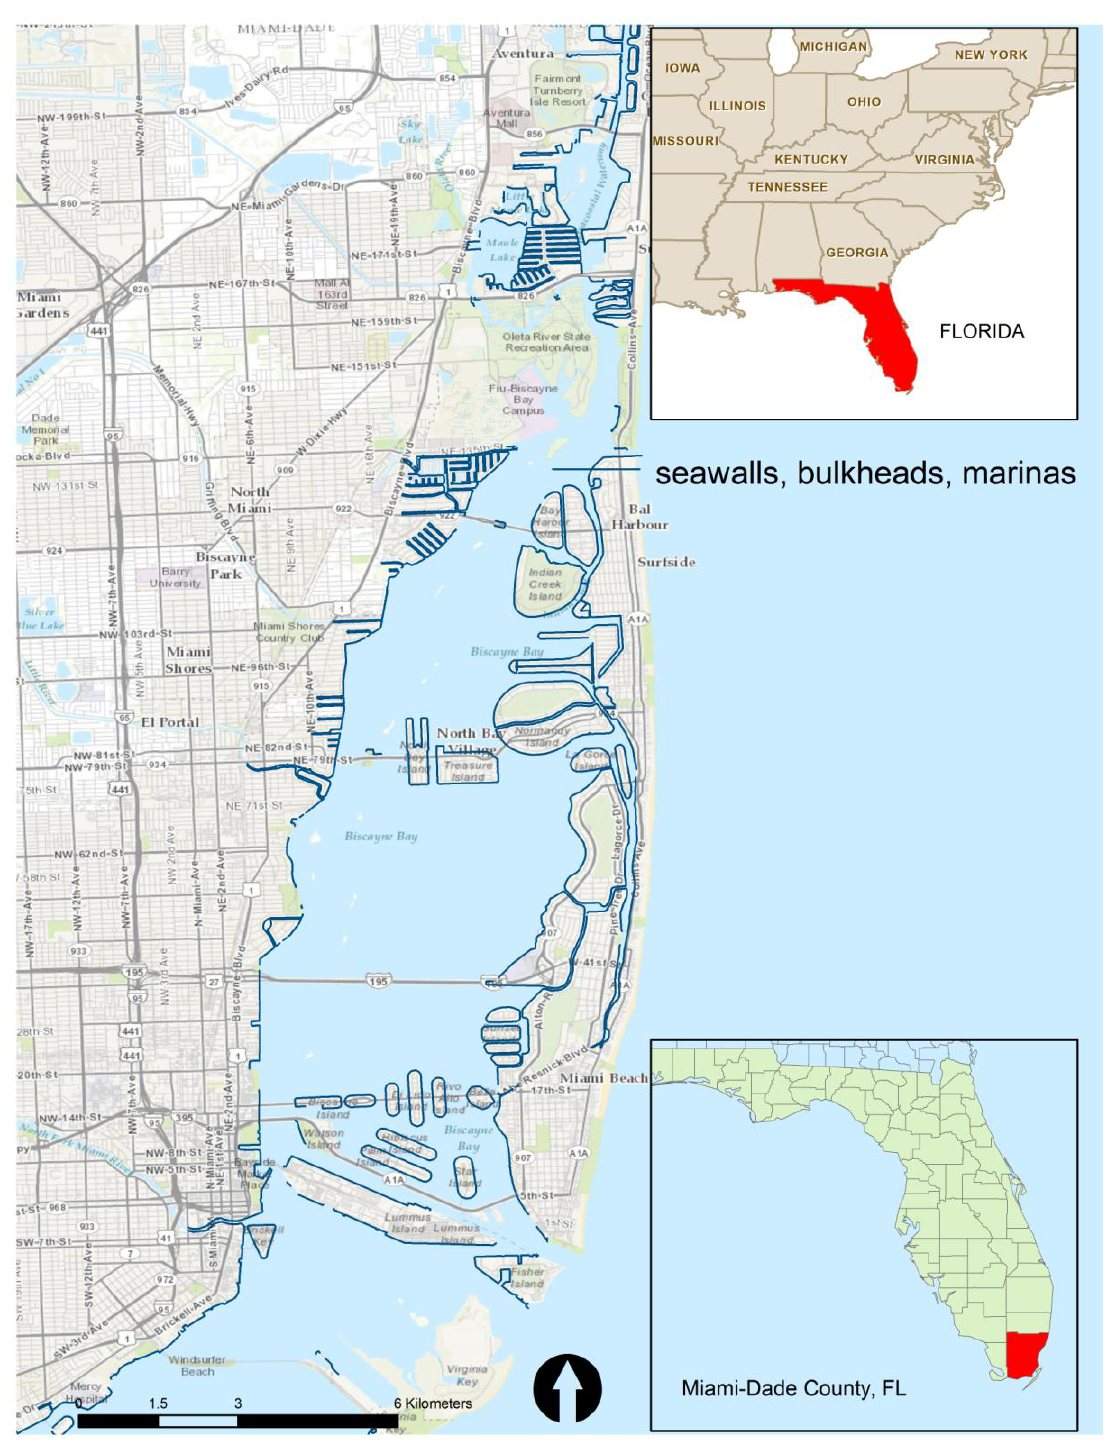
Figure 1. Location of the study area and extent of existing coastal